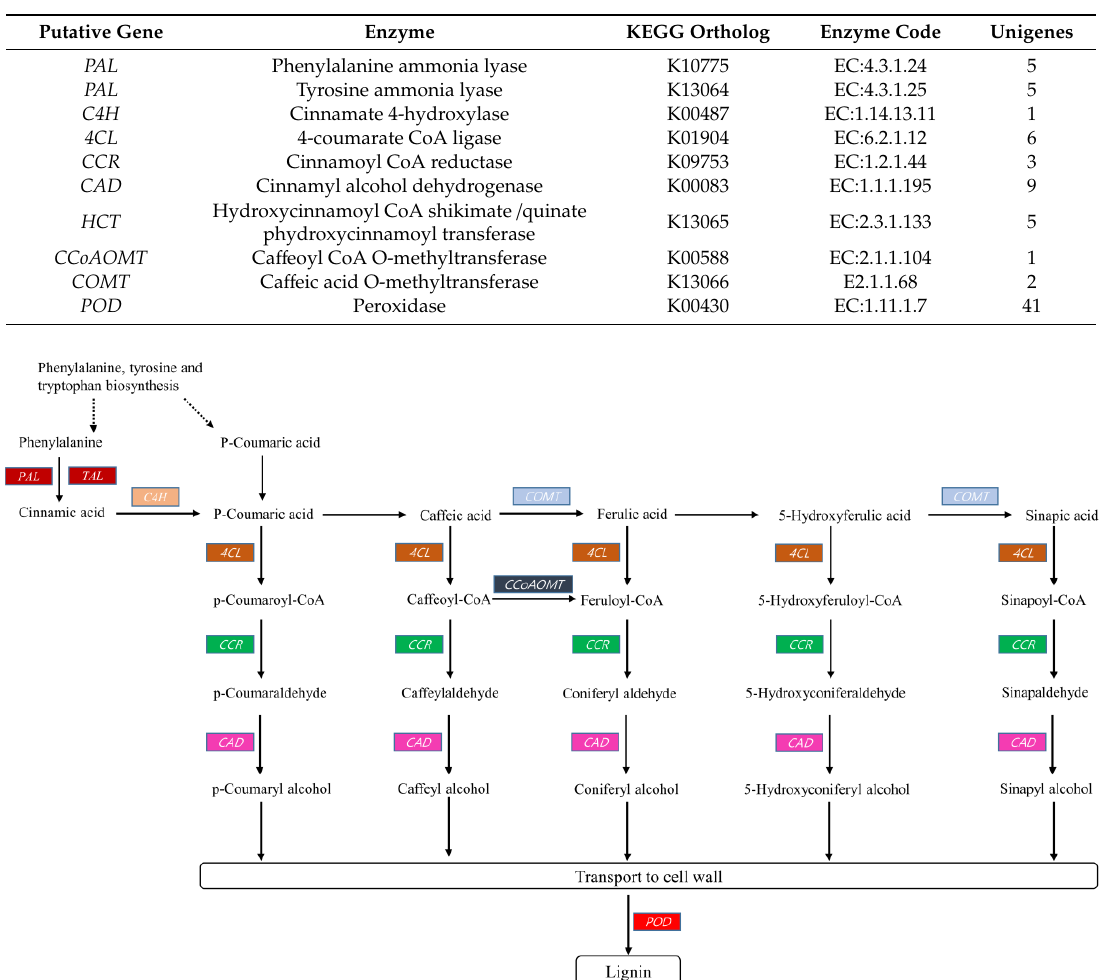
Table 3. List of candidate genes comprising lignin biosynthesis pathways found among kenaf unigenes.